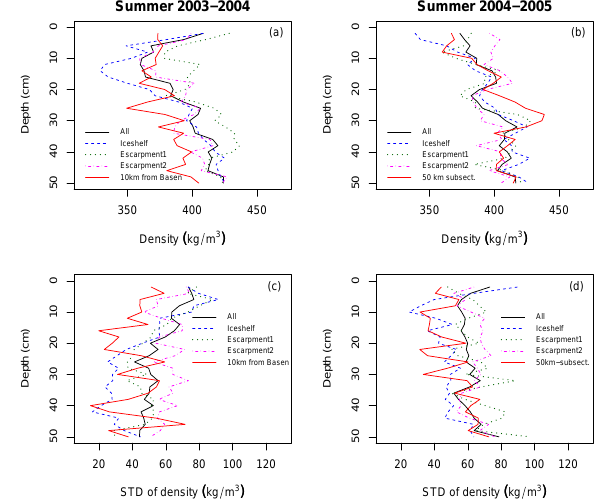
Fig. 9. Profiles of mean density (upper panels) and standard devi- ation of density (lower panels) from the 310km transect (from the entire transect and from separate sections of the transect), from a site 10km south of Basen, and from the 50km subsection during seasons 2003/2004 (left) and 2004/2005